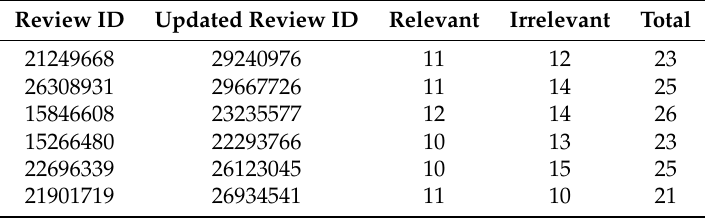
Table 1. Distribution of Relevant and Irrelevant articles in the data